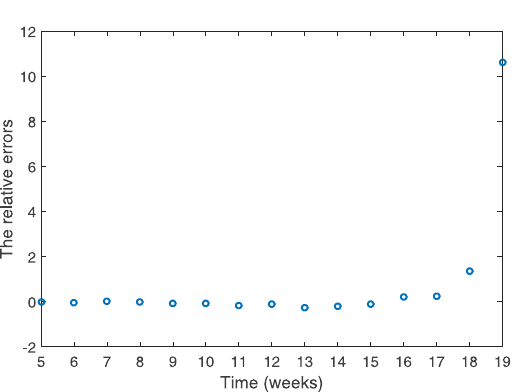
Figure 4. The relative error between theoretic and the real